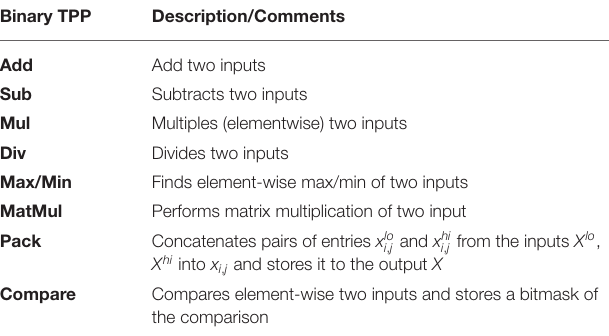
TABLE 2 | Binary TPPs. Binary TPP